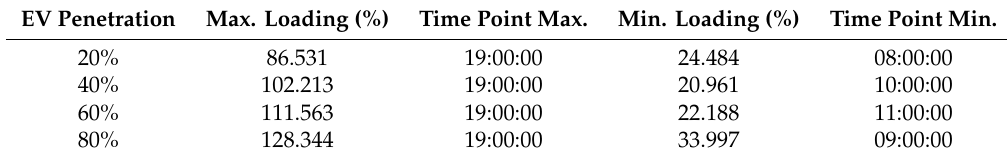
Table 2. Rural transformer loading data.